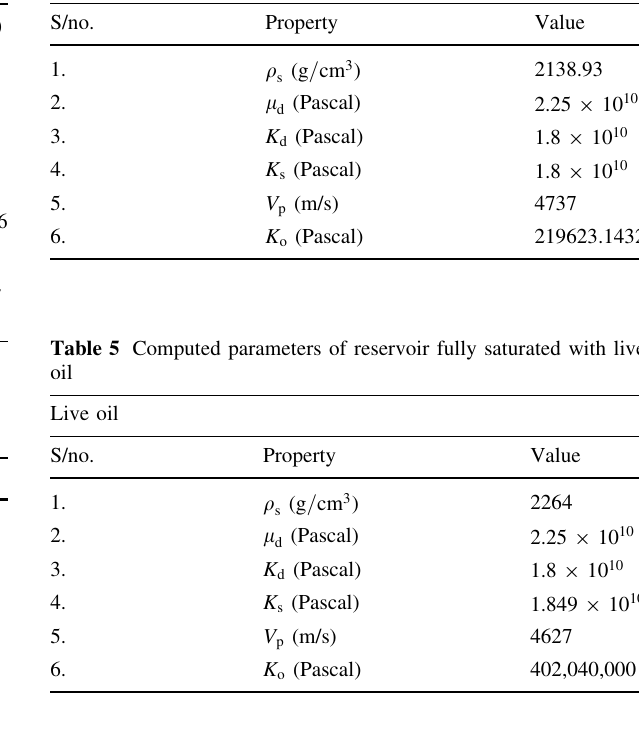
Table 4 Computed parameters of reservoir fully saturated with gas S/no.